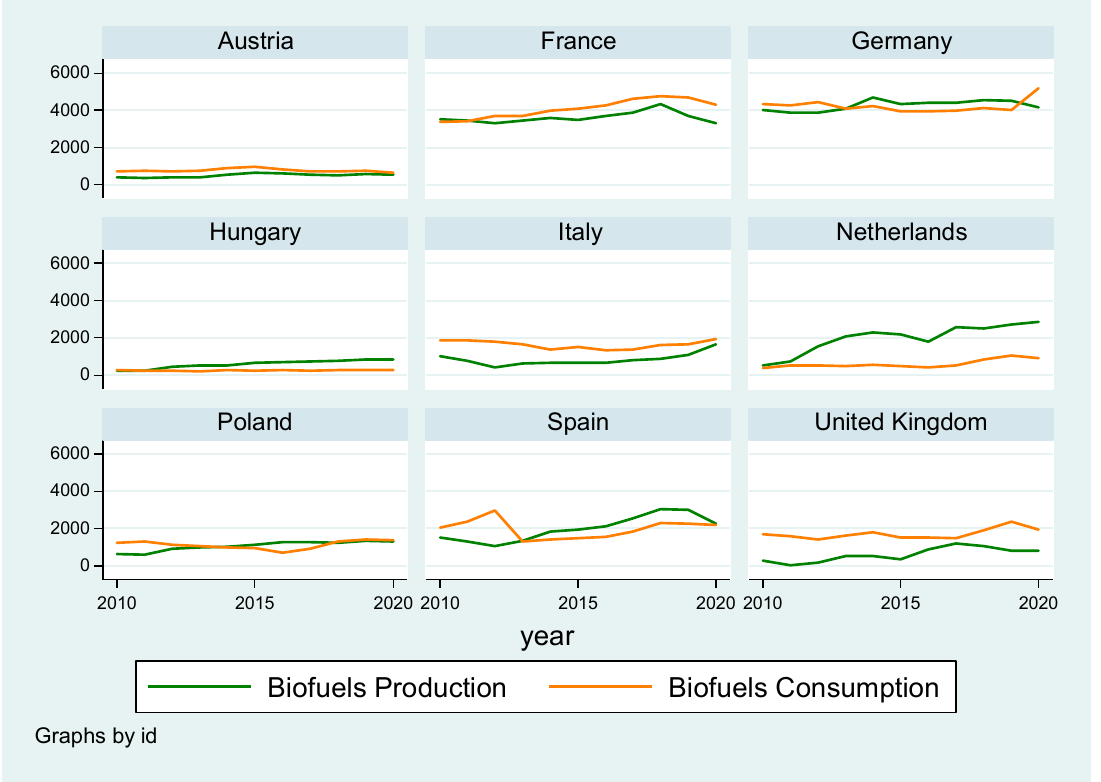
Figure 2. Dynamics of biofuel production and consumption in the European countries for 2010–2020, million liters. Note: Built based on the data from https://www.iea.org/reports/renewables-2021/biofuels, accessed on 10 July 2022.